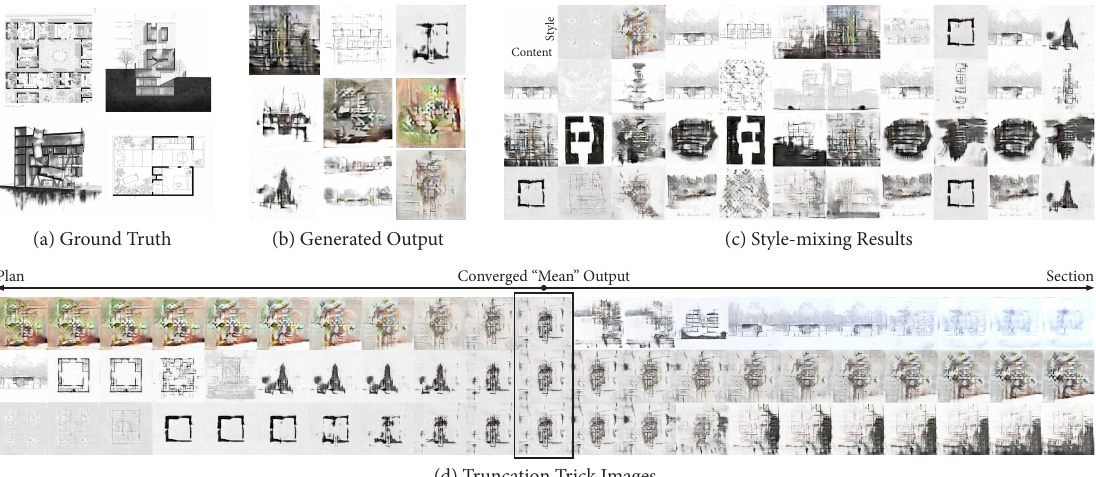
Figure 4. These are the training processes and results of collected plan and section drawings: ( a ) Example of input data. ( b ) Selected output fake images. ( c ) Contents, styles, and mixed results. ( d ) Continuing transforming images